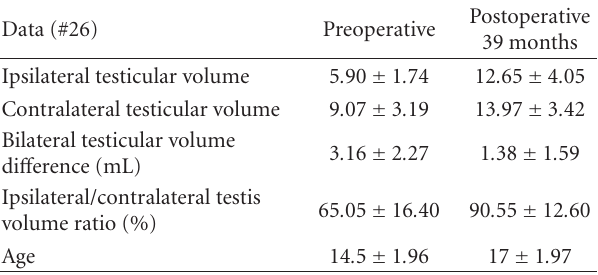
Table 1: The summary of preoperative and postoperative data of adolescent varicocele